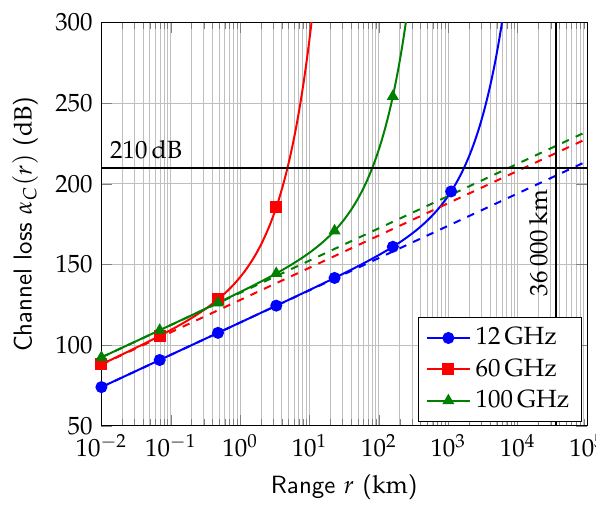
Figure 10. Channel loss for different frequencies as sum of free space path loss (dashed lines) and the atmospheric attenuation according to ITU standard atmosphere (solid lines) for homogenous medium between transmitter and receiver. As reference the properties of a geostationary satellite for broadcasting at K u -band (12GHz) with 36000km transmission range with approx. 210dB of insertion loss are highlighted.